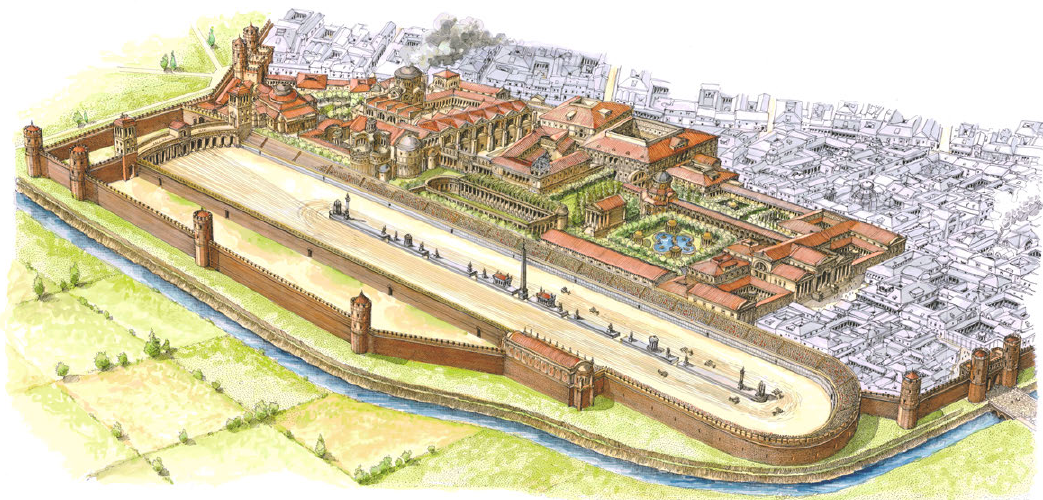
Figure 1. Reconstructive drawing of the Circus and the Imperial Palace (by F. Corni, courtesy of Civico Museo Archeologico di